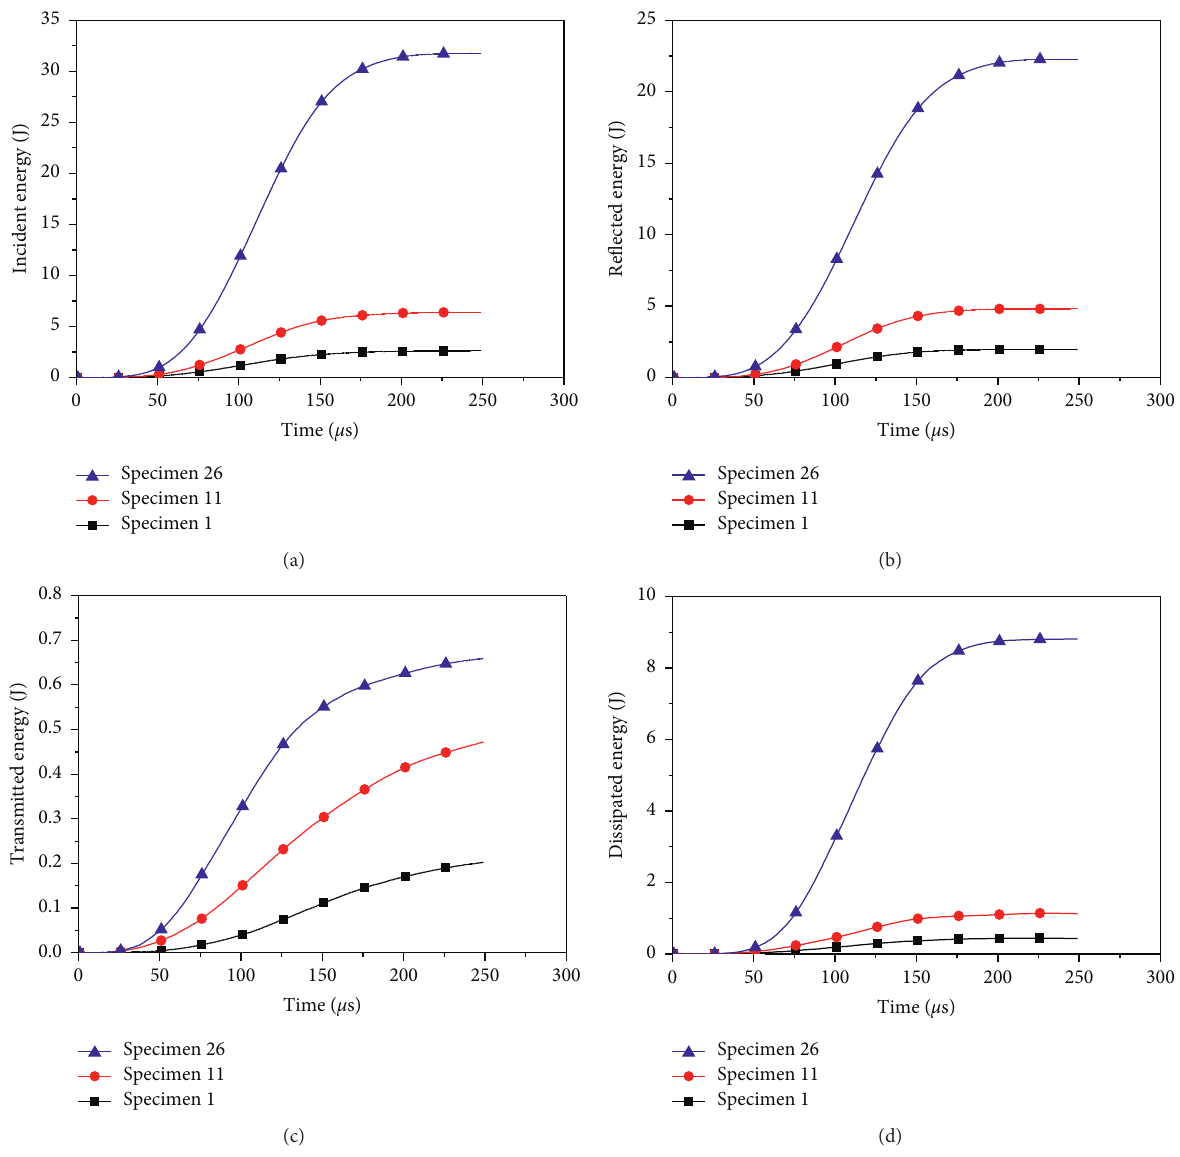
Figure 6: Energy-time curve of red sandstone specimens in the dynamic Brazilian disc test: (a) incident energy-time; (b) reflected energy- time; (c) transmitted energy-time; (d) dissipated